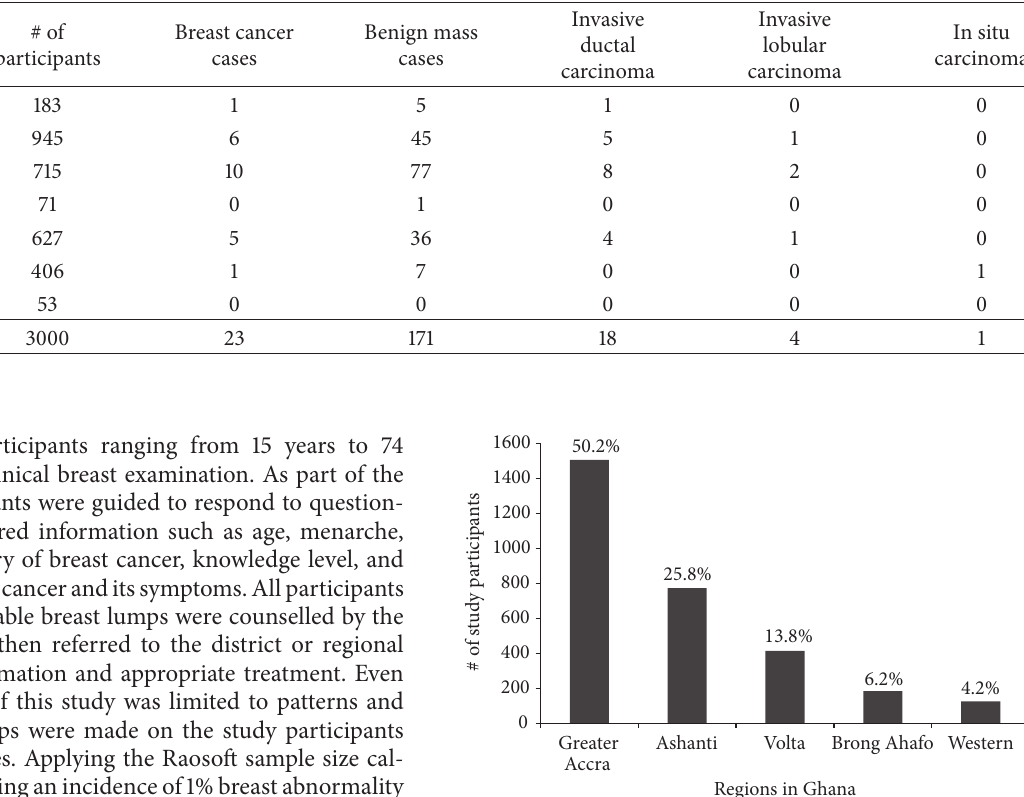
Table 1: Histological classification of breast cancer in relation to various age groupings. All histological classifications are based on examination of tissue specimens. Most of the cases were invasive ductal carcinomas.